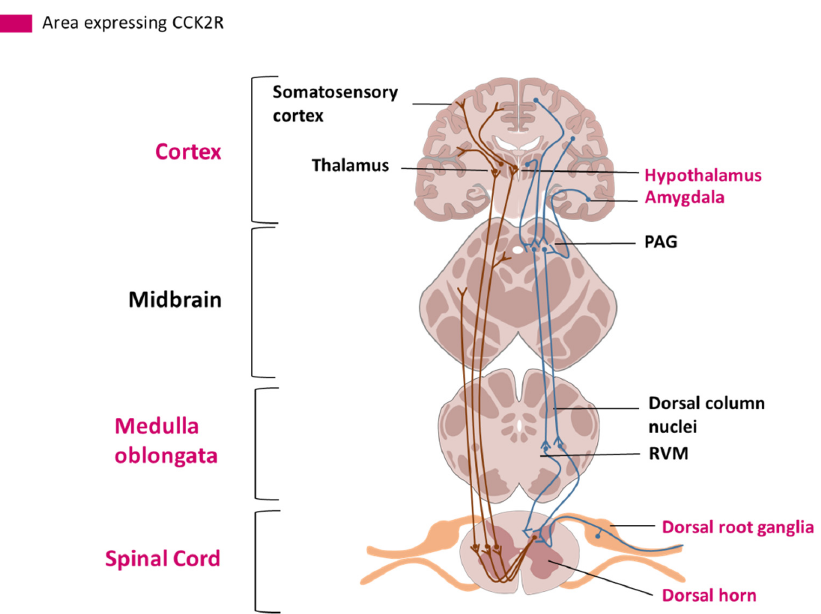
Figure 1. Representation of the spinothalamic tract and descending pain modulation pathway. Areas where CCK2R has been detected are labelled in pink. A: Ascending pain pathways. Nociceptors (C and A δ fibers) send pain information from peripheral tissues, their cell bodies are localized in the dorsal root ganglia (DRG). Fibers transmit nociceptive signals to a second order neuron in the dorsal horn of the spinal cord. The second order neuron then crosses over to the opposite side, where it forms the ascending spinothalamic tract. This tract takes signals to nuclei in the medulla oblongata and midbrain on the way up to the thalamus. The thalamus relays the information to the somatosensory and insular cortex, as well as cortical regions mediating different aspects of the pain experience such as affective responses in the cingulate cortex. B: Descending pain modulation pathways: Information from the environment and some motivational states can activate this top- down pathway. Several areas in the limbic forebrain including the anterior cingulate and insular cortex, nuclei in the amygdala and the hypothalamus, project to the midbrain periaqueductal grey (PAG), which then modulates ascending pain transmission from the afferent pain system indirectly through the rostral ventromedial medulla (RVM) in the